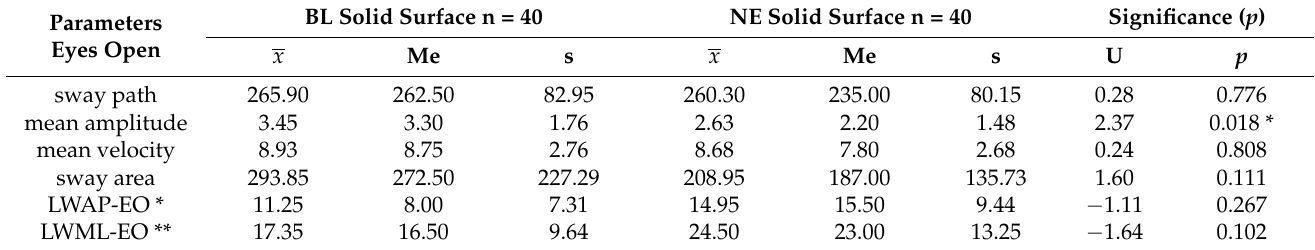
Table 4. Comparison of the results on the platform between the groups; solid surface, eyes open, eyes